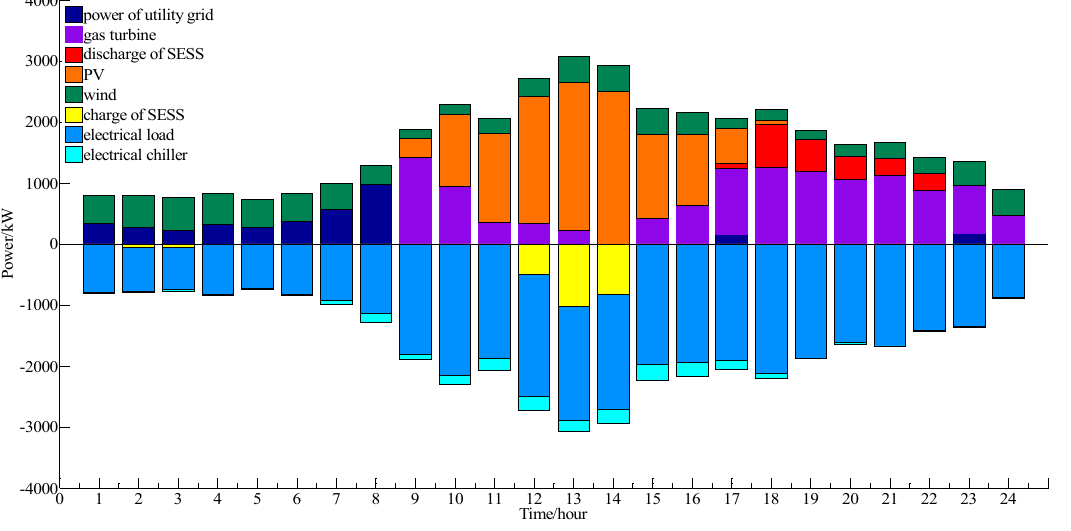
Figure 5. Electrical power of each device in RES.